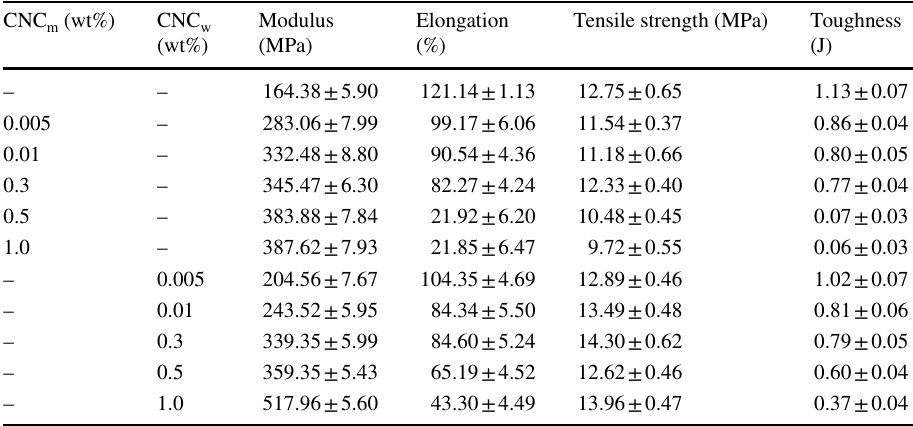
Table 1 Tensile properties of the PU/PVDC/CNC composite films